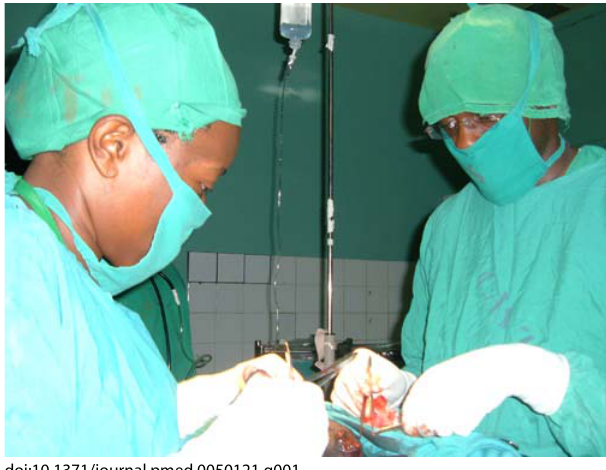
Figure 1. Surgical Training in Sub-Saharan Africa